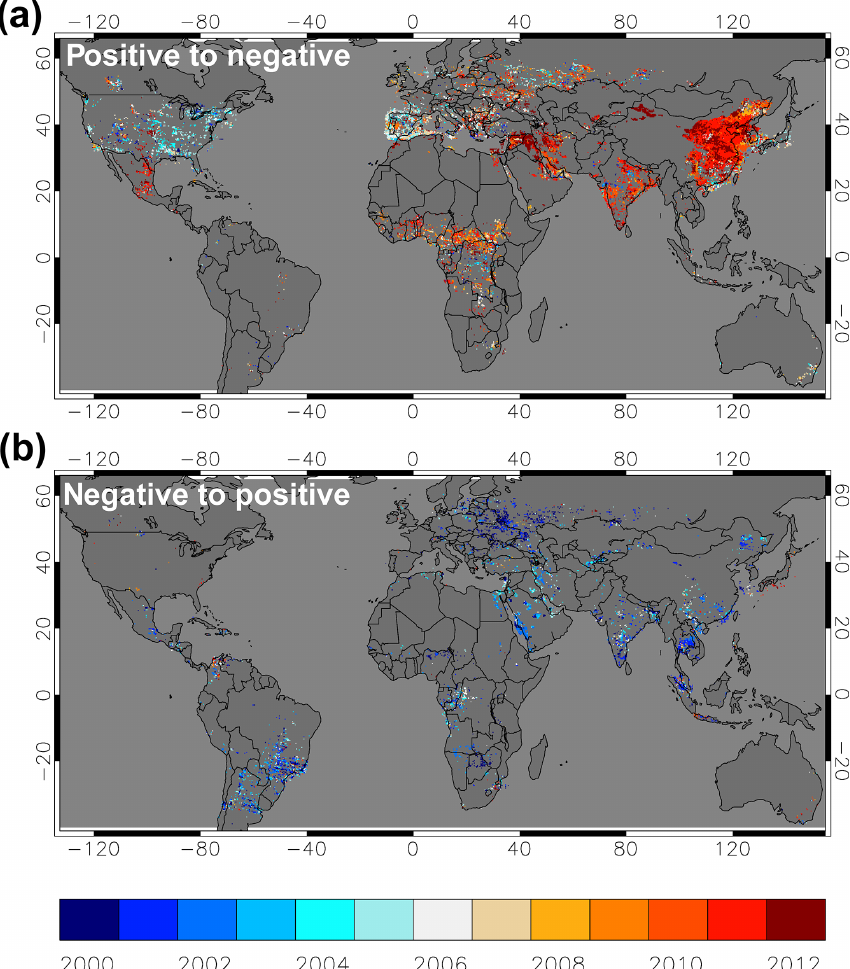
Figure 4. Year of tropospheric NO 2 VCD trend reversal from positive to negative (a) and from negative to positive (b) . Only grid cells with a statistically significant trend at the 95% confidence level for the period before or after the year of reversal and with a long-term tropospheric NO 2 VCD mean of at least 1 × 10 15 moleculescm − 2 are